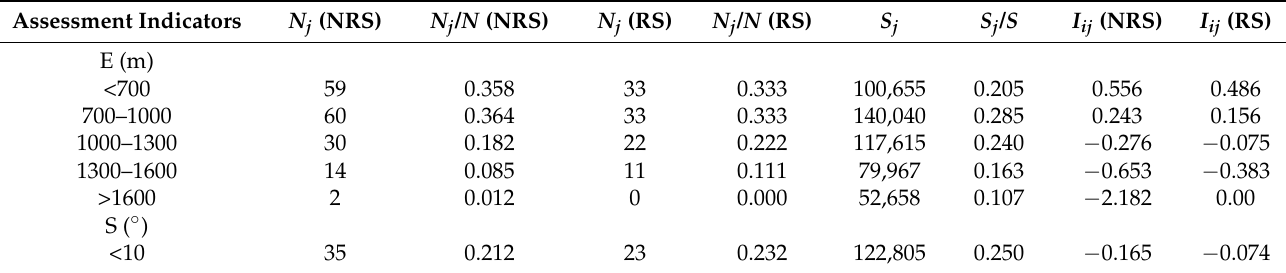
Table 6. Information quantity for each assessment